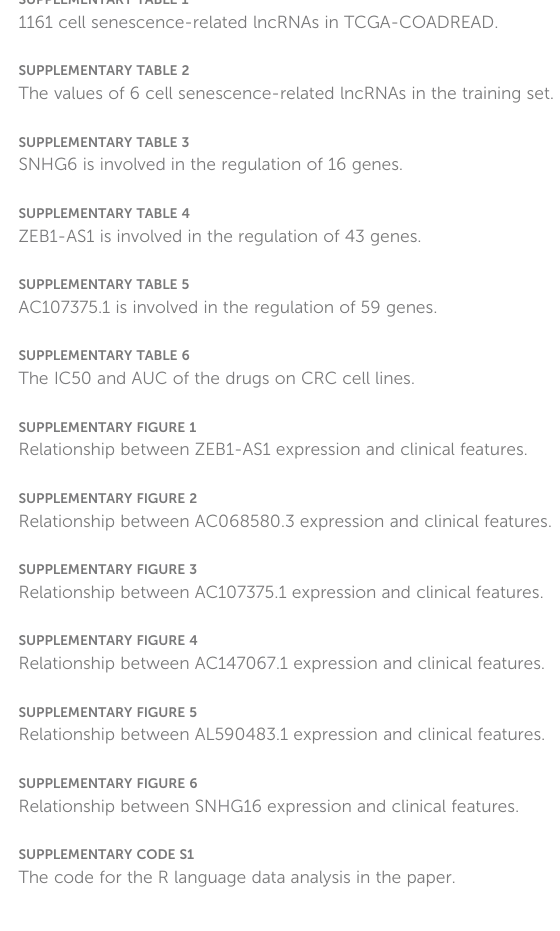
SUPPLEMENTARY TABLE 3 SNHG6 is involved in the regulation of 16 genes.